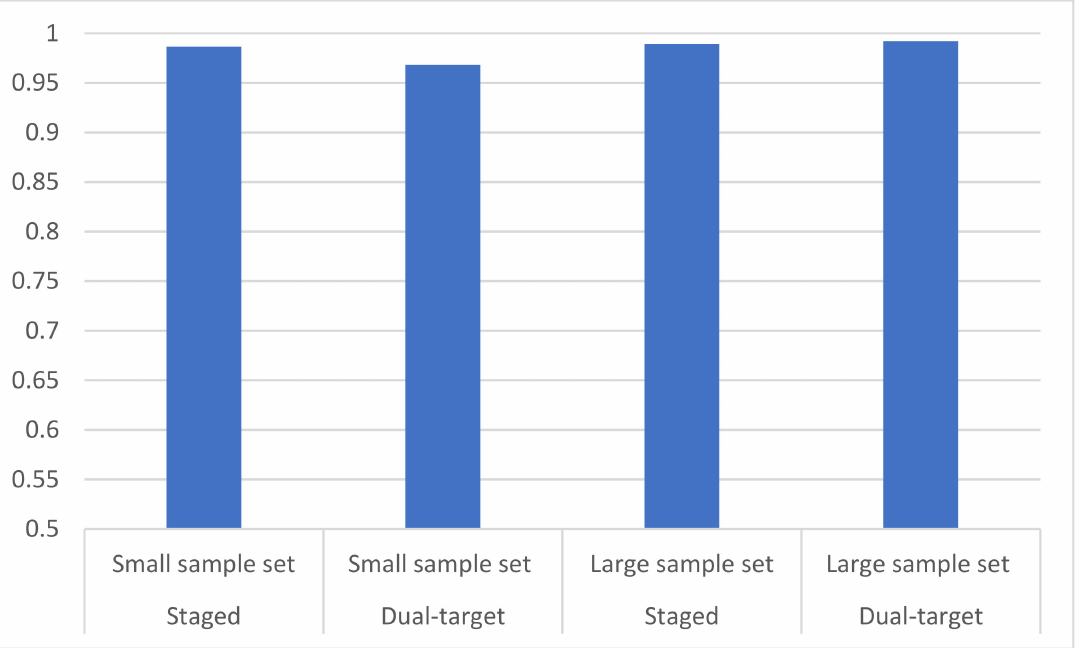
Figure 14. Comparison of the detection accuracy of the staged detection classification method and dual-target detection classification method.